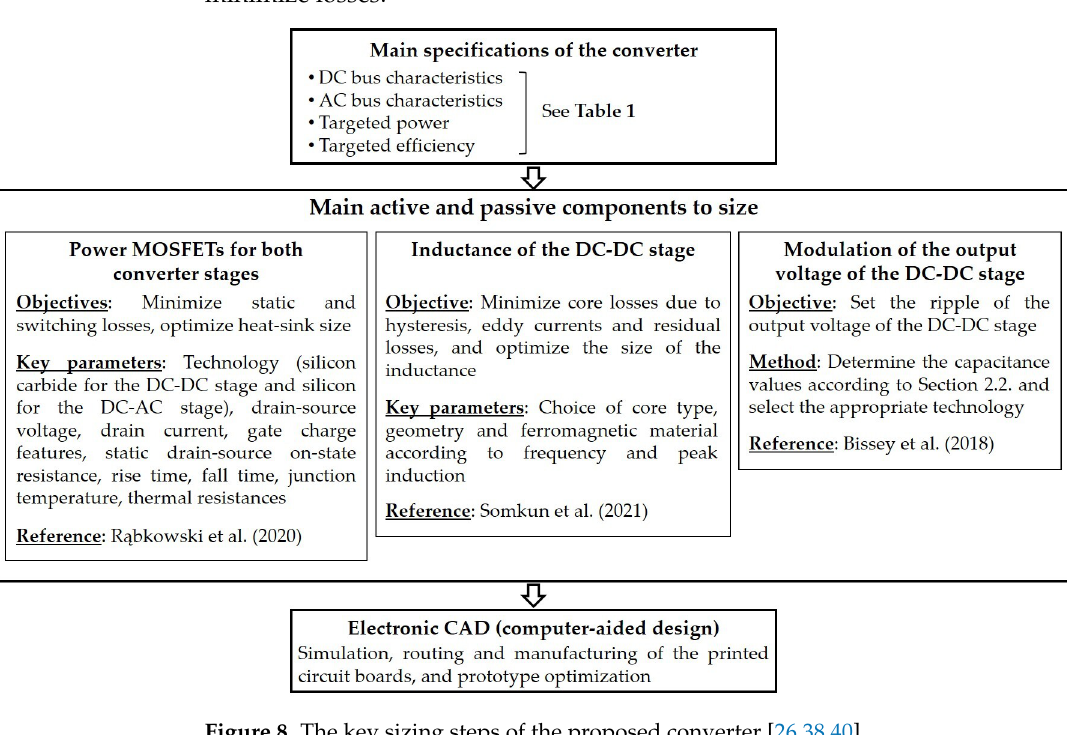
Figure 8. The key sizing steps of the proposed converter [26,38,40].